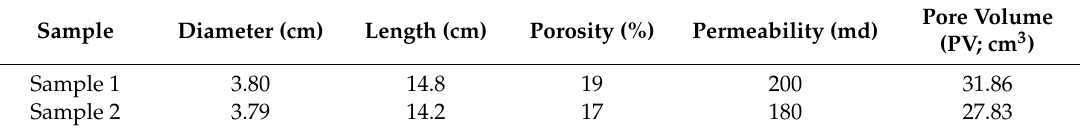
Table 4. Rock properties of Berea core samples used in coreflooding